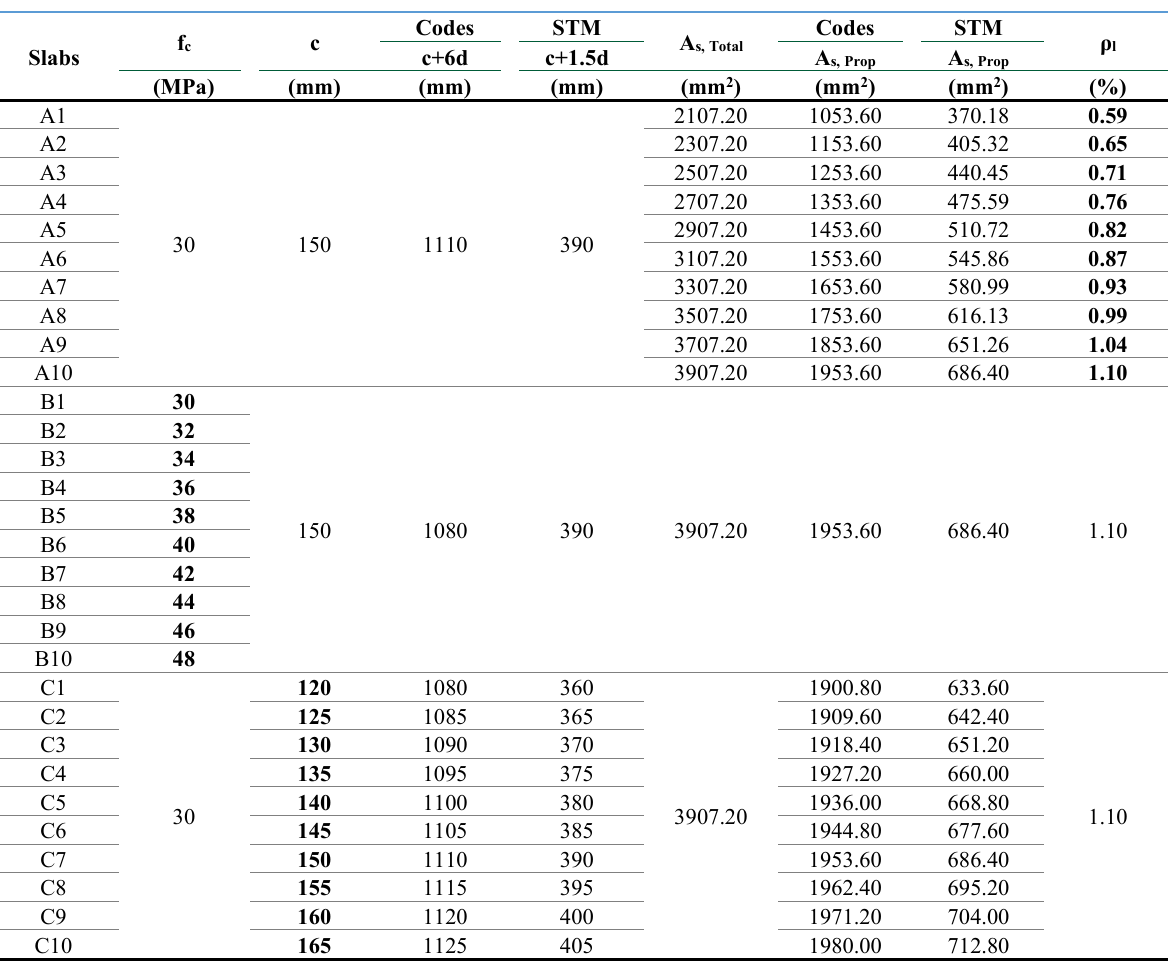
Table 1. Data from the analyzed